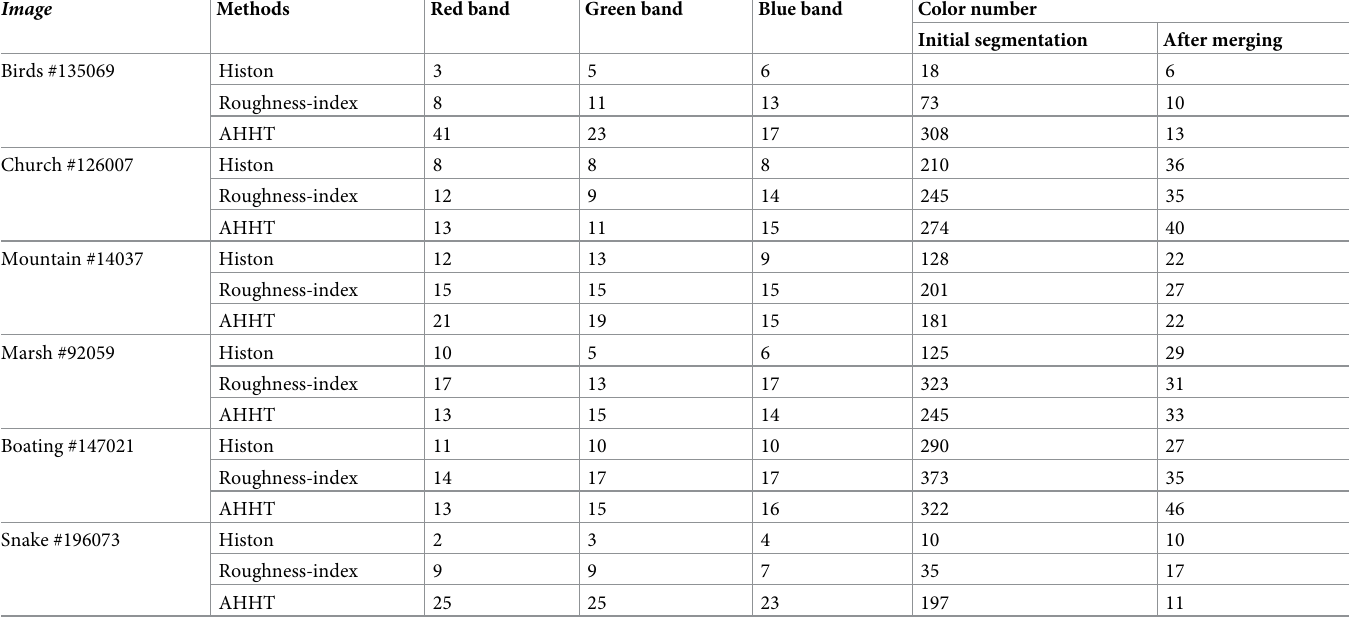
Table 1. Comparison of the number of thresholds and the color number in the initial segmented result and the result after merging. Image